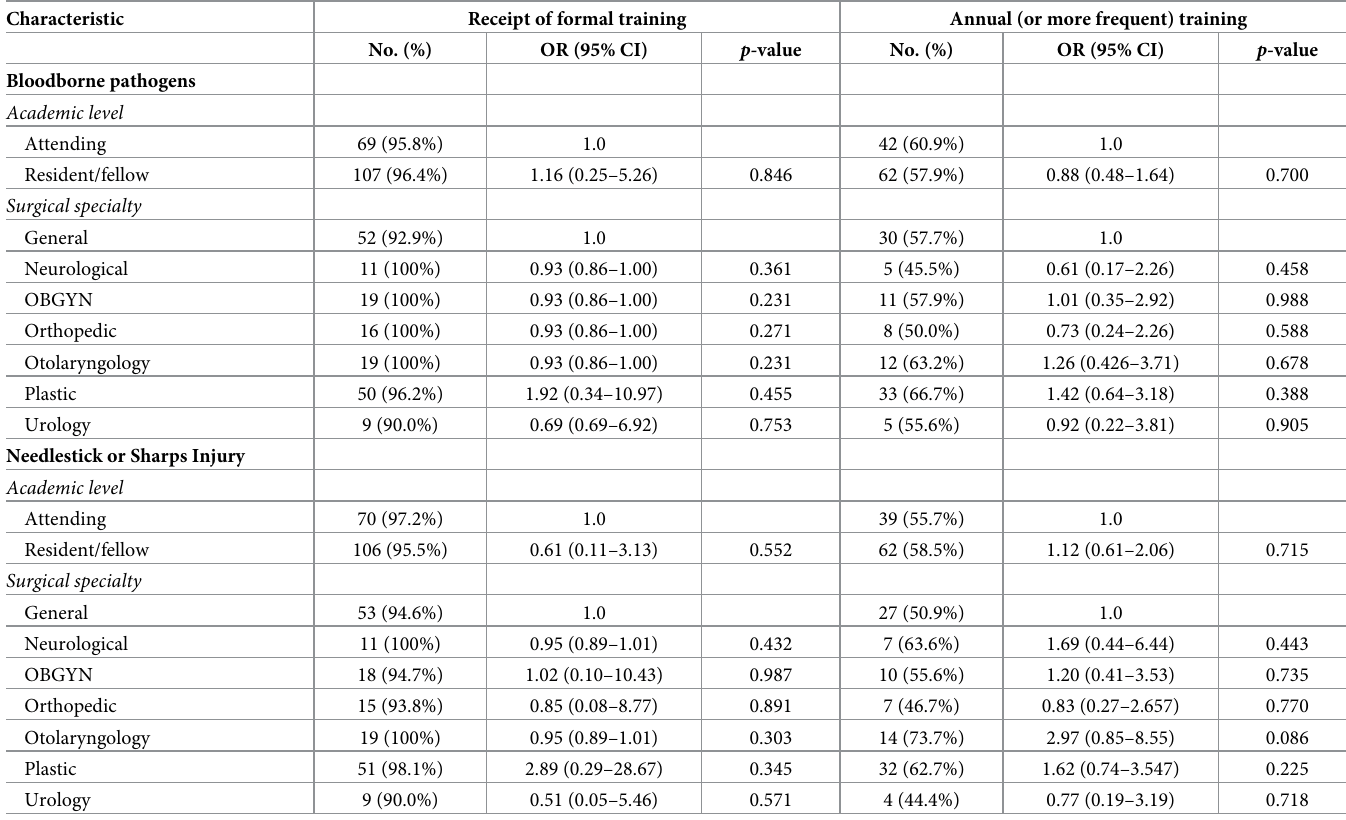
Table 1. Receipt and frequency of formal training for biological occupational hazards stratified by academic level and surgical specialty.